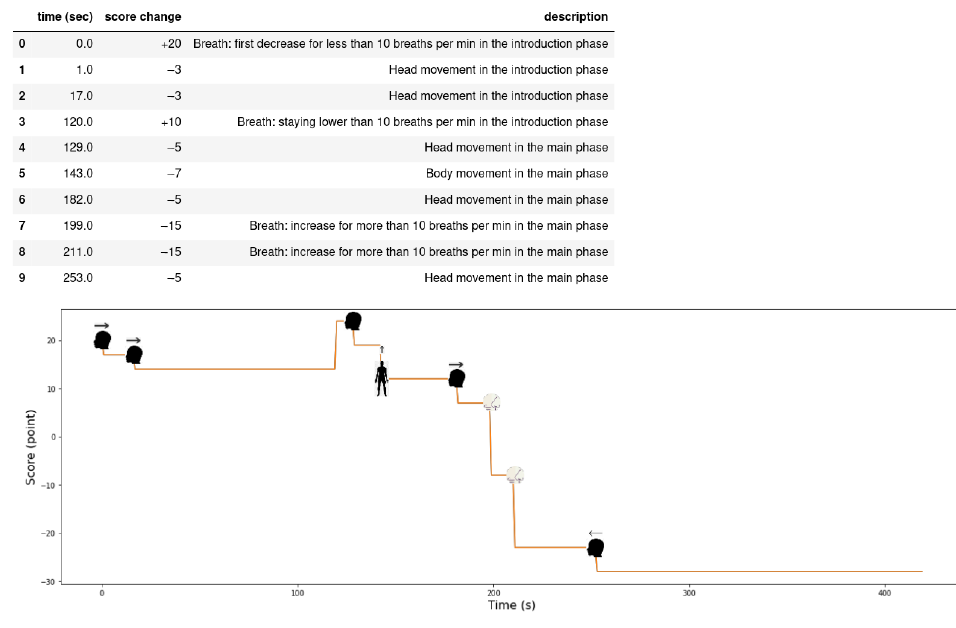
Figure 16. Meditation evaluation for a beginner meditator.